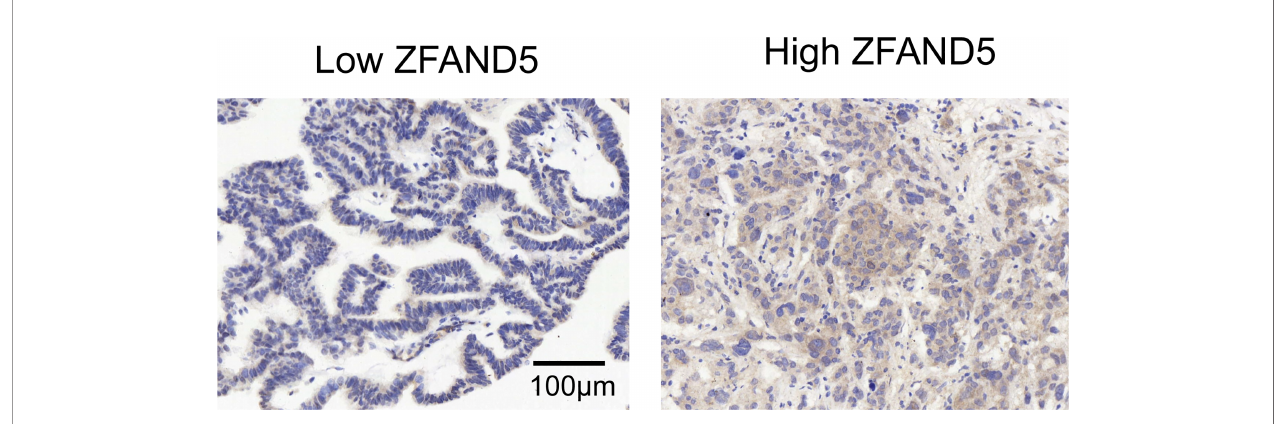
FIGURE 2 | The cohort was divided into ZFAND5low and ZFAND5high subsets. The representative images of low and high ZFAND5 expression. Scale bar: 100 m m.